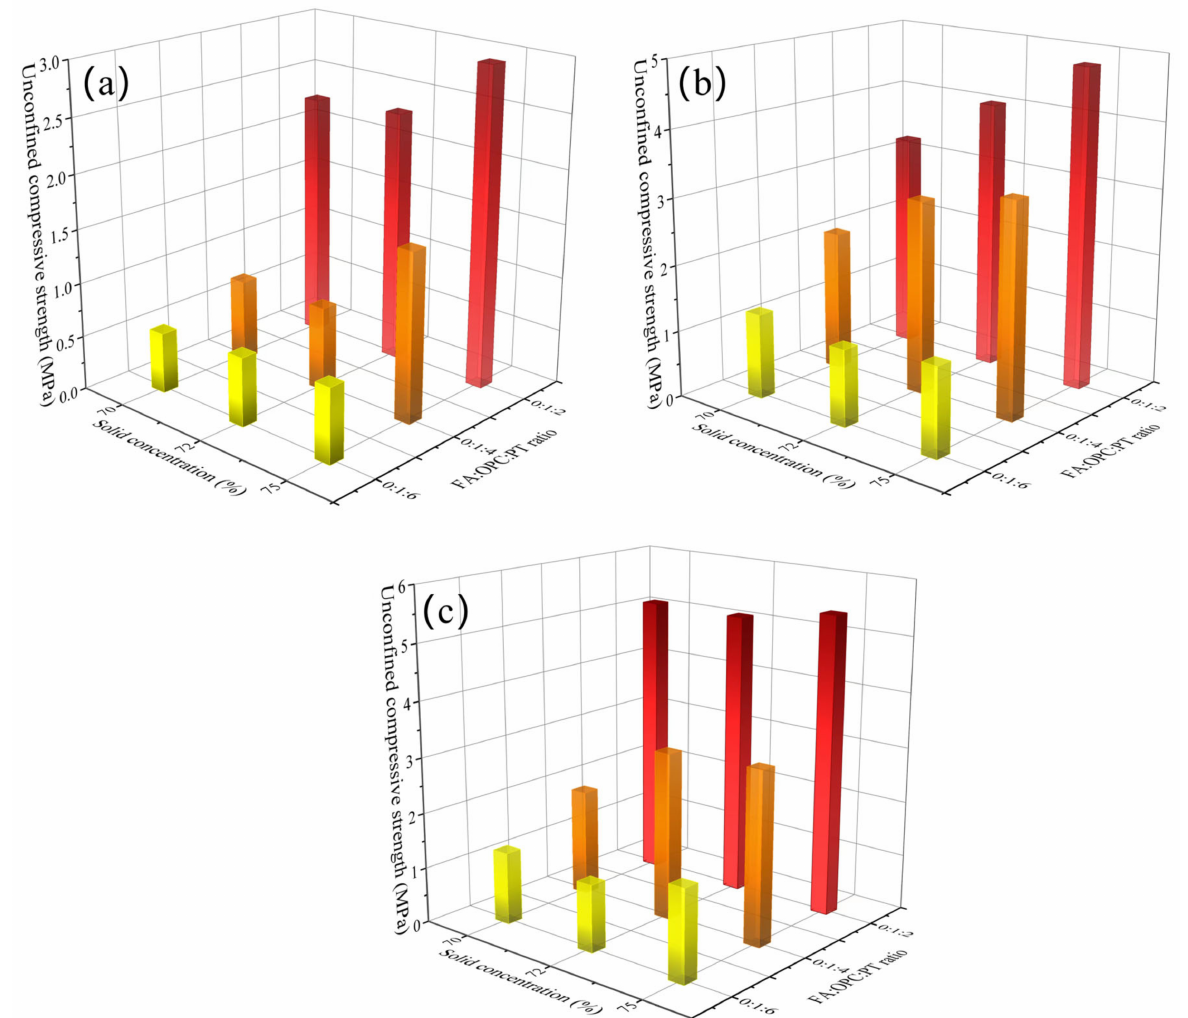
Figure 3. Variation of the UCS of backfill specimens with FA:OPC:PT ratio and solid concentration (using sole OPC as the binder): ( a ) 7 days; ( b ) 14 days; ( c ) 28 days. It was observed that the UCS is positively related to the binder/aggregate ratio and solid concentration. As shown in Figure 3a, when the solid concentration increased from 70% to 75%, the UCS of backfill specimens with an FA:OC:PT ratio of 0:1:2, 0:1:4, and 0:1:6 increased by 28.7%, 102.6%, and 23.2%, respectively. The refinement of pores by high solid FA:OPC:PT ratio varied from 0:1:6 to 0:1:2, Figure 3a shows that the UCS of the backfill samples with solid concentrations of 70%, 72%, and 75% increased by 4.1 times, 3.67 times, and 4.3 times, respectively. The greater quantity of hydration products induced by a